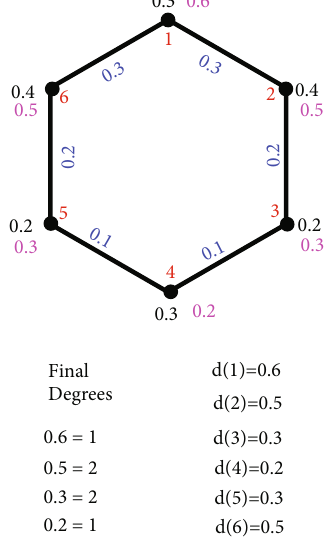
Figure 1: (1, 1) unit of fuzzy graph of